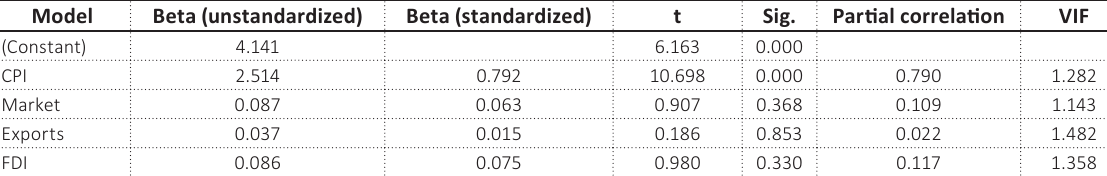
Table 7. Main results for Model